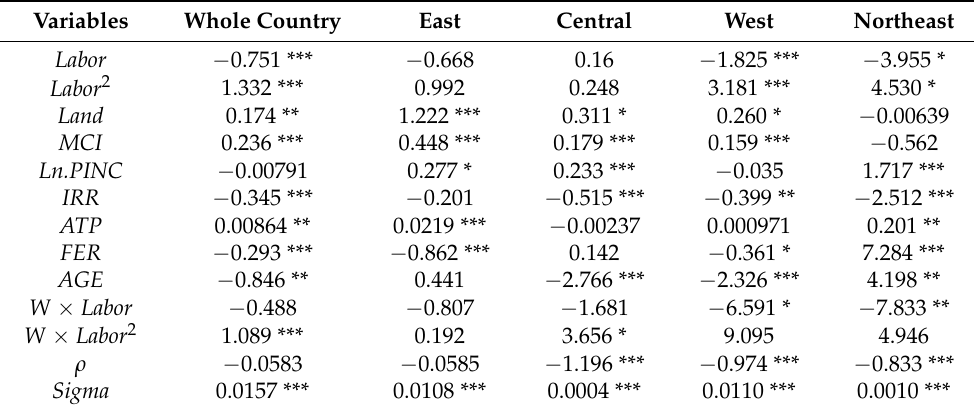
Table 3. The SDM regression results for the whole country and individual Chinese regions.